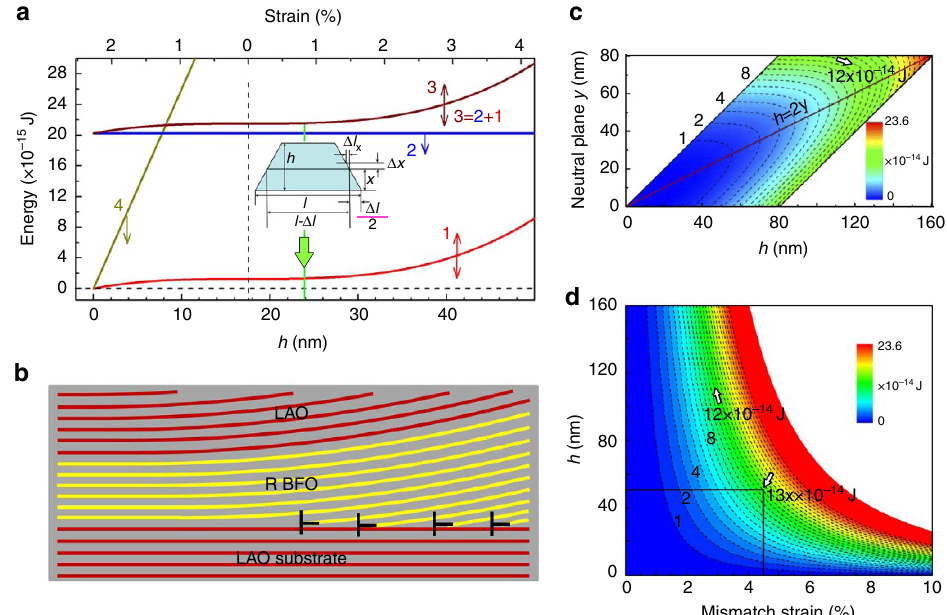
Figure 5 | Low elastic energy states for BiFeO 3 disclinations. ( a ) Comparisons of elastic energies for BiFeO 3 nanostructures under linear strain gradient and homogeneous 2D strain. The inset in a is a schematic indicating the elastic energy calculation involving the strain gradient. Curve 1 is the elastic energy distribution of a BiFeO 3 nanostructure under linear strain gradient. Curve 2 is the interfacial dislocation energy of the BiFeO 3 nanostructure. Curve 3 is the whole energy of the BiFeO 3 nanostructure calculated through 1 þ 2, which represents the energy consumption for producing the experimentally observed disclinations shown in Fig. 1. Curve 4 is the elastic energy of a same sized BiFeO 3 nanostructure under fully 2D strain on the assumption that the BiFeO 3 nanostructure is fully strained by the mismatch ( B 4.5%). The black dotted line indicates the neutral plane where the BiFeO 3 lattices are under free strain. The green arrow indicates the thickness termination ( B 24nm) of the present BiFeO 3 nanostructure (Fig. 2d). Note that, compared with the fully 2D strained state, the present observed disclination strain states exhibit almost negligible elastic energy consumptions, especially when the thickness of the nanostructure tends to smaller. A schematic illustration of the disclination formed through interfacial dislocation arrays is shown in b . The elastic energy consumption distribution versus thickness ( h ) and the location of neutral plane ( y ) of the BiFeO 3 nanostructure under linear strain gradient is shown in c . The elastic energy consumption distribution versus thickness ( h ) and mismatch of the same size BiFeO 3 nanostructure under fully 2D strained state is shown in d . By comparing c and d , it is obvious that for large mismatch systems with small thickness, the BiFeO 3 nanostructure under linear strain gradient exhibits negligible elastic energy consumption compared with the fully 2D strained state.